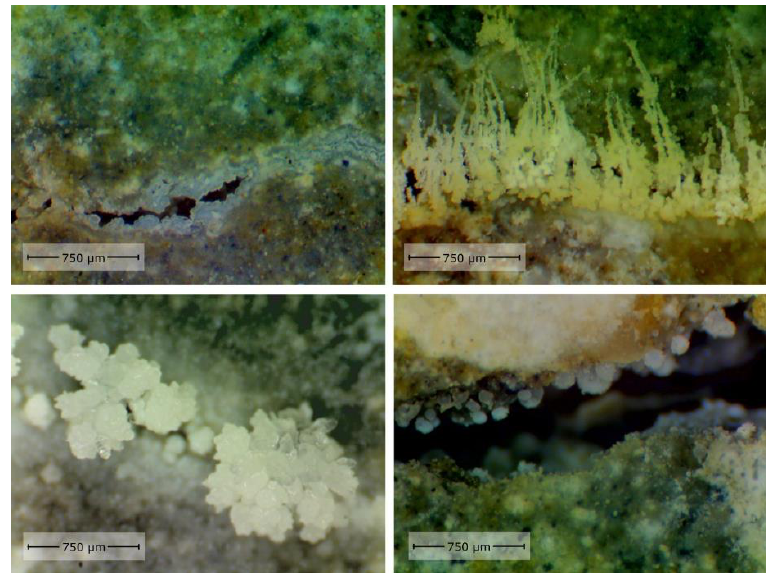
Figure 1. Crystal morphology of healing products. Reprint with the permission from ref.[11]. Copyright 2021 Elsevier.